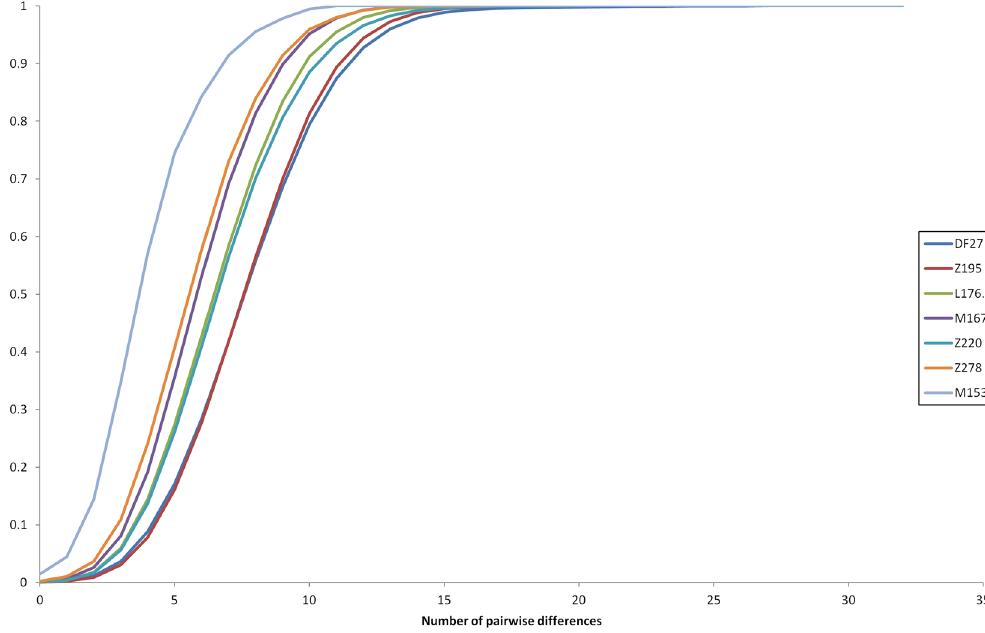
Figure 5. Cumulative distributions of the number of pairwise absolute differences in repeat size among individuals, by